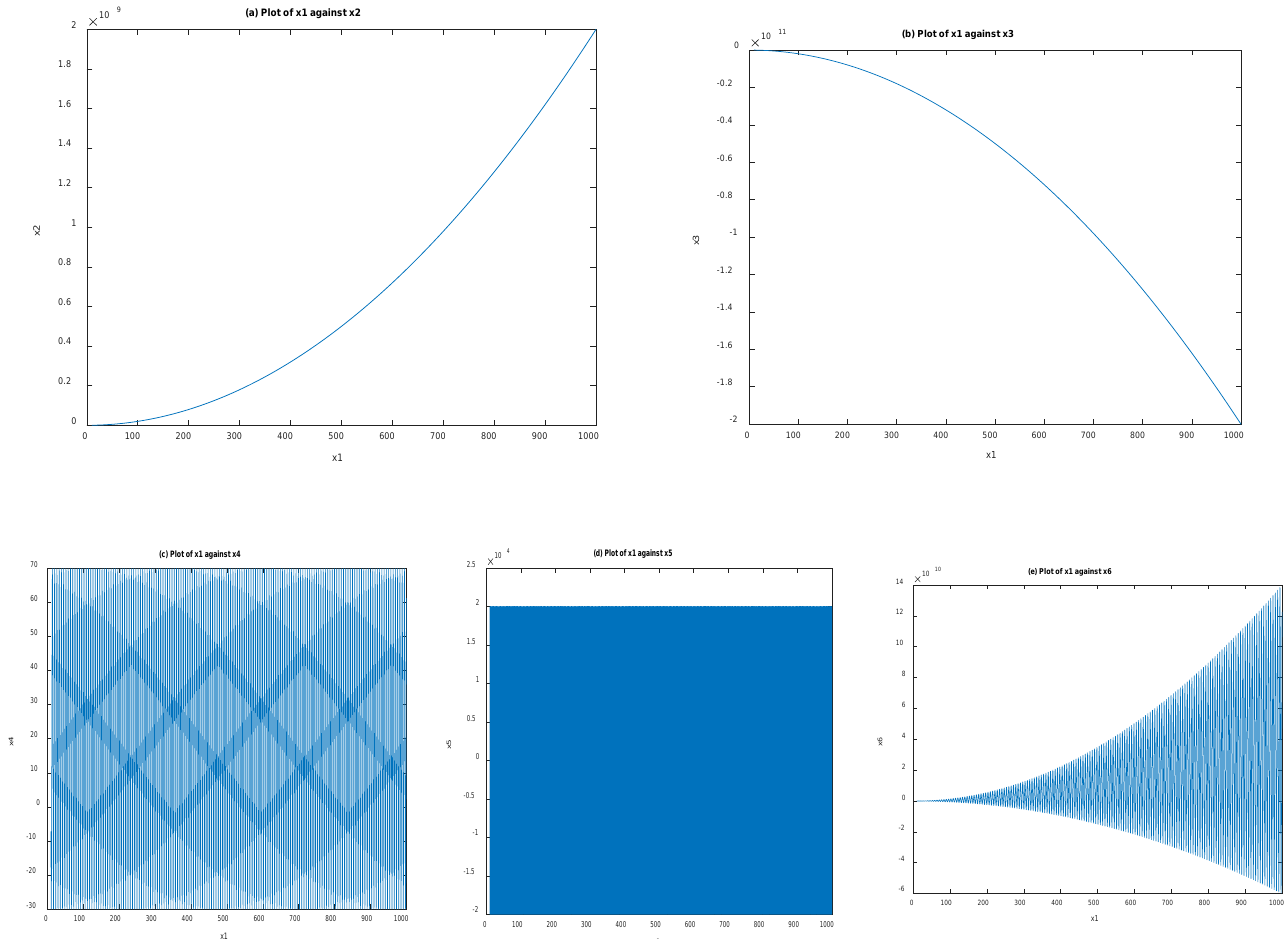
Figure 4. Simulation of the CB model of SoTE for x 1 = 1:0.0005:100. ( a )input quadratic function, ( b ) input quadratic function, ( c ) resultant polynomial function, ( d ) induced interference ( e ) output wave function.